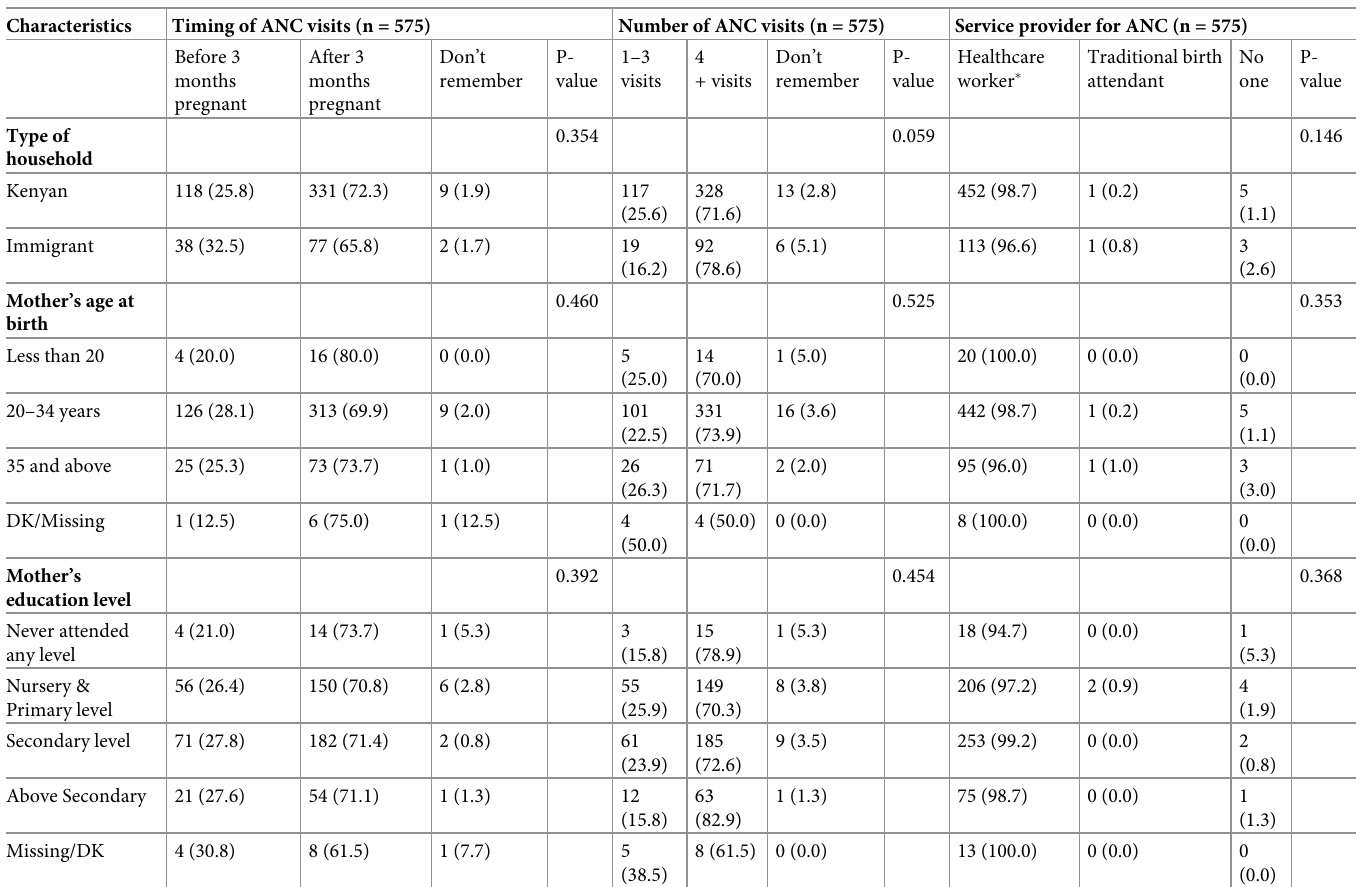
Table 3. Antenatal care seeking practices of mothers during their pregnancy for the previous birth.